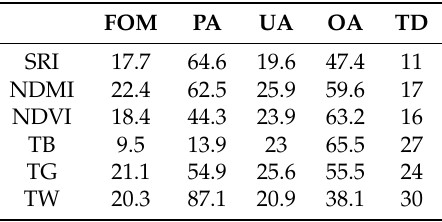
Table 2. FOM (%), PA (%), UA (%), OA (%) and (observation) at the Brazilian site. A mean model is used in the MEFP for the method introduced here (SRI), and a first-order harmonic model is used for the other